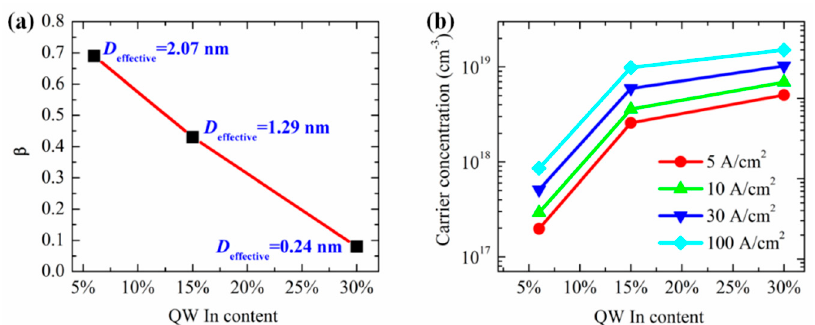
Figure 3. ( a ) QW In composition-dependent β and ( b ) carrier density at various current densities varied from 5 to 100 A/cm 2 .